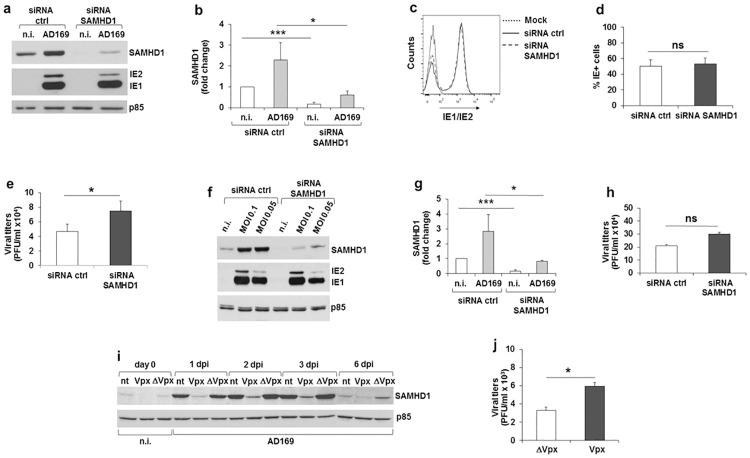
SAMHD1 knock-down by siRNA or Vpx expression and effect on HCMV replication.a-h) HFFs were transfected with SAMHD1 siRNA or non-targeting siRNA (ctrl). Two days later, cells were either infected with AD169 at an MOI of 1 and harvested at 3 dpi (a-e) or infected at an MOI of 0.1 or 0.05 and harvested at 6 dpi (f-h). a) Levels of SAMHD1 and IE1/IE2 viral protein expression were assayed by immunoblotting. The p85 subunit of PI3K was used as loading control. One representative experiment is shown. b) The relative amount of SAMHD1 protein, normalized to that of p85, was determined by densitometric analysis and is relative to that of n.i./siCtrl cells, which was arbitrarily set as 1. Data are expressed as mean ± SE. c) The percentage of IE+ cells was analyzed by FACS after intracellular staining with a specific anti-IE1/IE2 mAb. FACS plots derive from one representative experiment. d) The percentage of IE+ cells is expressed as mean ± SD, as detected by FACS. e) Cell culture supernatants were assayed for infectious virus production by plaque assays. Results are expressed as mean ± SE. All data in panels a-e derive from five independent experiments. f) Immunoblotting at 6 dpi was performed as described in panel a). One representative experiment out of two is shown. g) The relative amount of SAMHD1 protein was determined as in panel b). Data are expressed as mean ± SE of two independent experiments with cells infected at both MOI. h) Viral titers were measured and expressed as in panel e) and derive from cell culture supernatants of two independent experiments, were HFFs were infected at an MOI of 0.1 or MOI of 0.05 for 6 days. i-j) HFFs were infected with single-cycle VLPs loaded with Vpx (Vpx) or unloaded (ΔVpx) at an MOI of 1, and then the same cells were infected with AD169 at an MOI of 1. At different dpi, cells and supernatants were harvested and subjected to immunoblotting and plaque assays, respectively. i) Immunoblotting of SAMHD1 protein expression. One representative experiment out of three is shown. j) Cell culture supernatants were assayed for infectious virus production by plaque assays. Results are expressed as mean ± SE of four experiments at 2–3 dpi. nt, not treated; n.i., not infected cells; *, p < 0.05; ***, p < 0.001; ns, not significant.